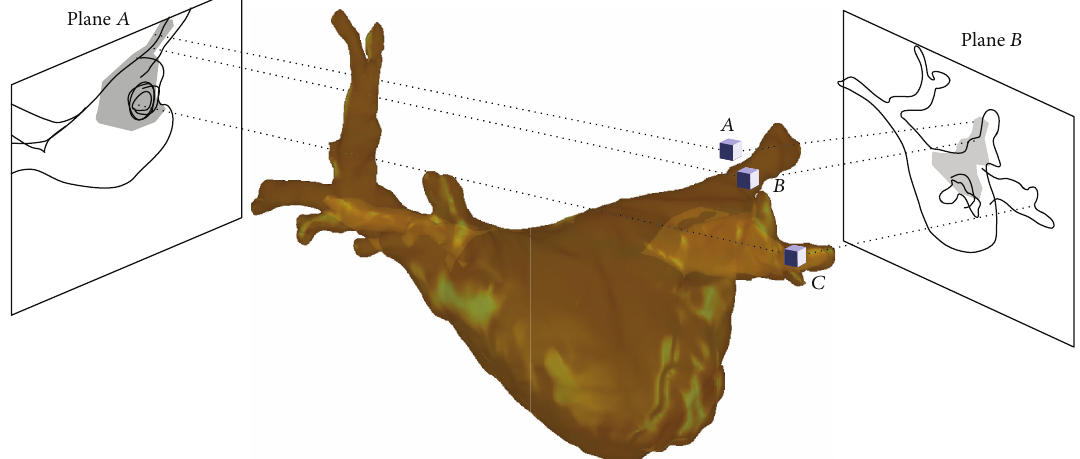
Figure 5: For the transformation shown, only voxel B is estimated as containing CA as it is inside the LA and contrasted in both planes. Voxel C is only contrasted in plane A but not in plane B. Voxel A is filled with contrast in both planes, but it is outside of the LA and therefore considered as uncontrasted. If the LA is moved such that its projections in A and B cover the contrasted area, this voxel will also be considered as contrasted, hence, increasing the consistency with the